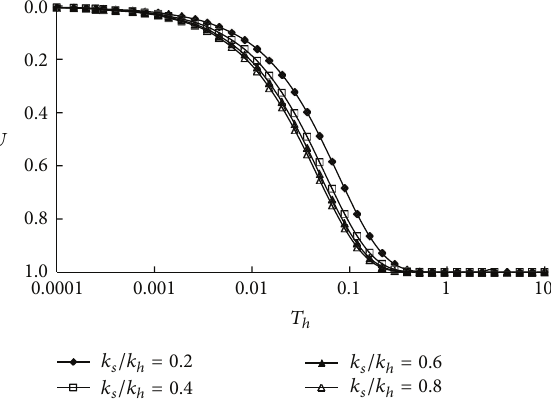
Figure 7: Influence of 𝑎 on consolidation process.